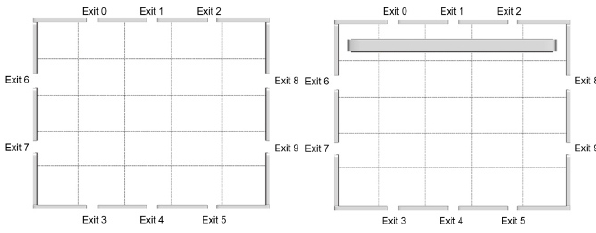
Fig. 17 Example hall, maps for comparisons with the GA method. Left: environment without an obstacle. Right: environment with a rectangular obstacle.